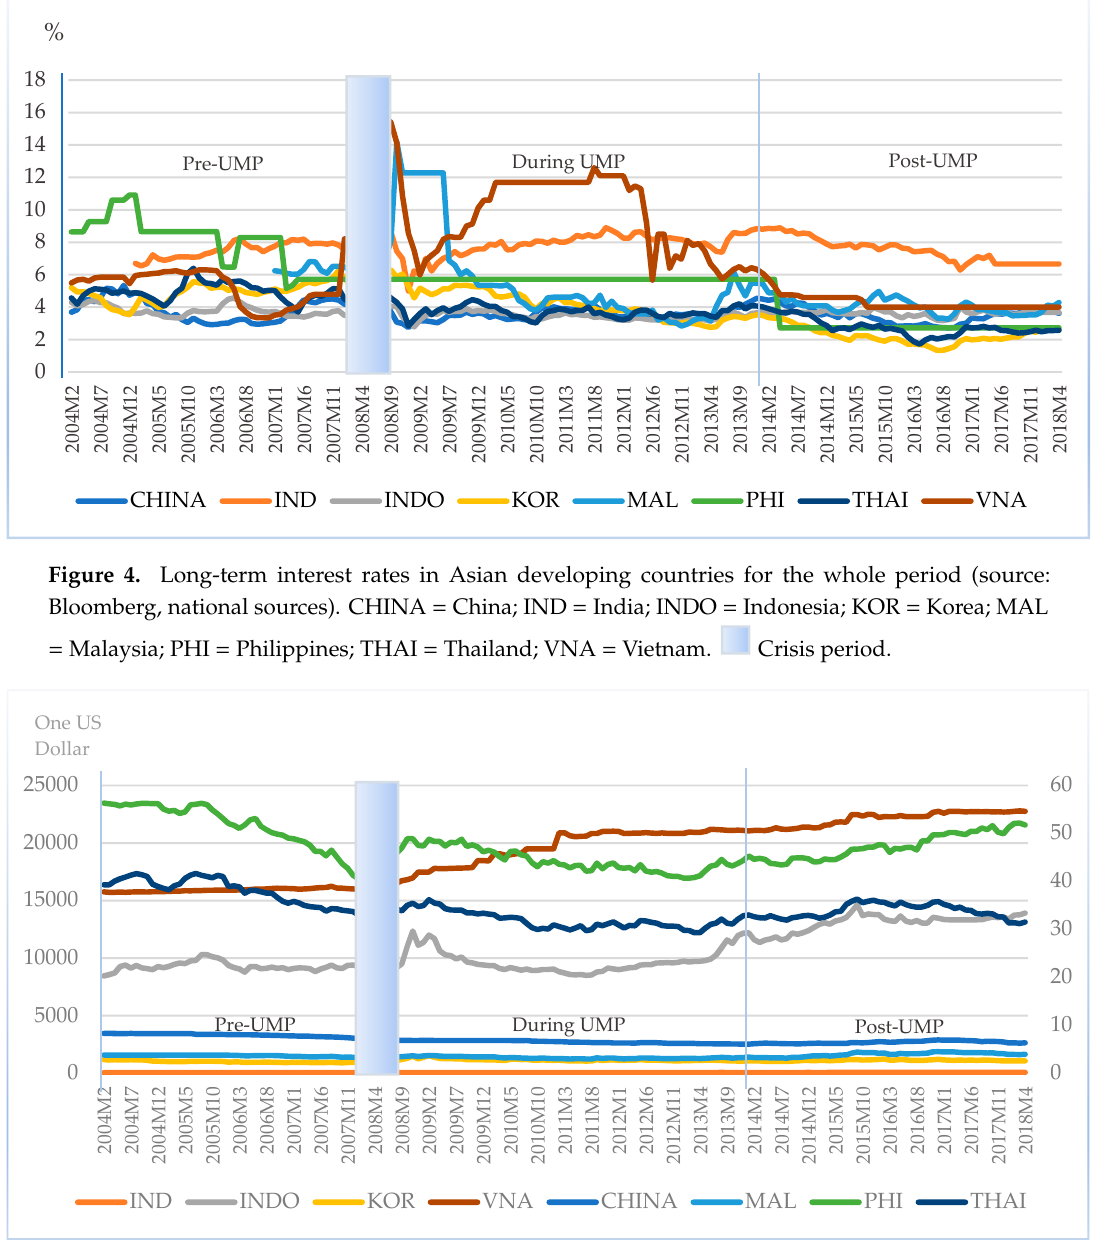
Figure 5. Exchange rates in Asian developing countries for the whole period (source: Bloomberg). CHINA = China; IND = India; INDO = Indonesia; KOR = Korea; MAL = Malaysia; PHI = Philippines; THAI = Thailand; VNA = Vietnam. Crisis period.